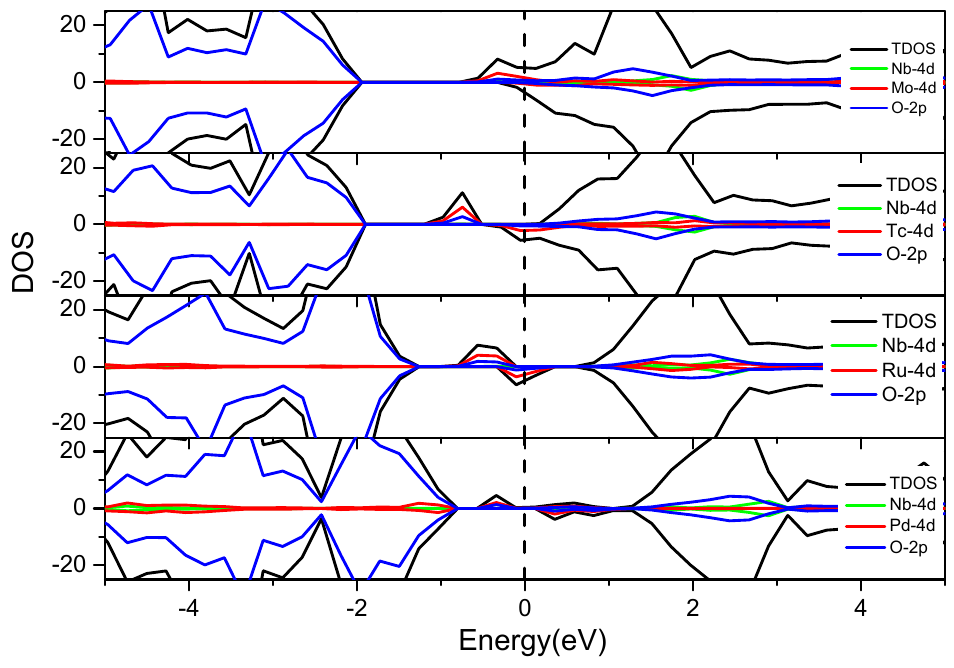
Figure 9. The total and partial density of states of the Nb-M ″ (4d metal elements: Mo, Tc, Ru and Pd) co-doped BaTiO 3 . The black dashed line indicates the position of the Fermi level.